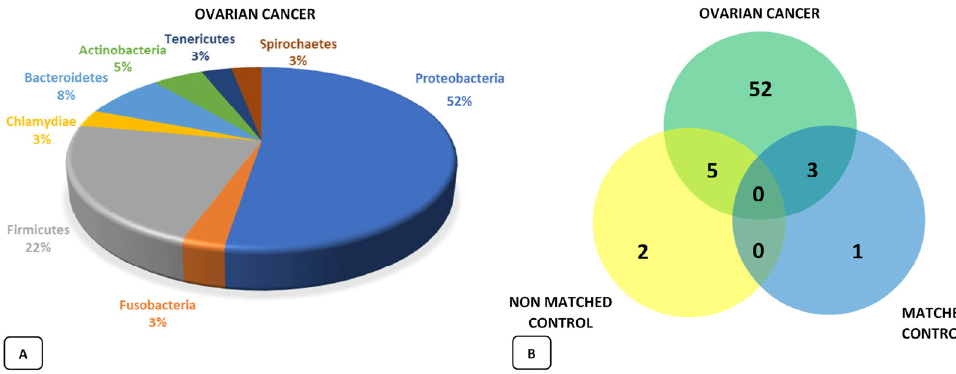
Figure 3. Bacterial signature identified in ovarian K-tissue: microbial composition in tumor tissues ( A ); Venn diagram with the evident preponderance of bacterial species only present in pathological tissues ( B ) [22].